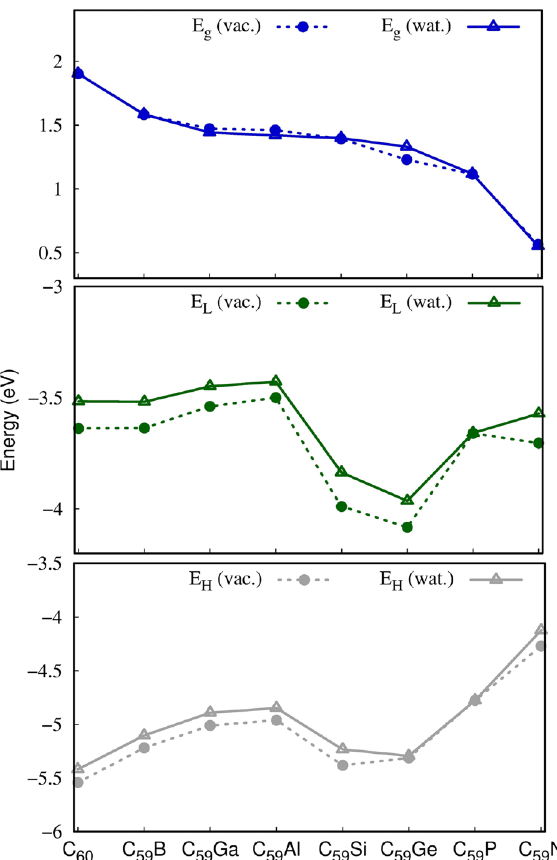
Figure 1. Frontier orbital energies and HOMO–LUMO orbital energy gap of the doped fullerenes as determined at the M06/6-31G(d)//ωB97XD/6-31G(d) level of theory in vacuum and water